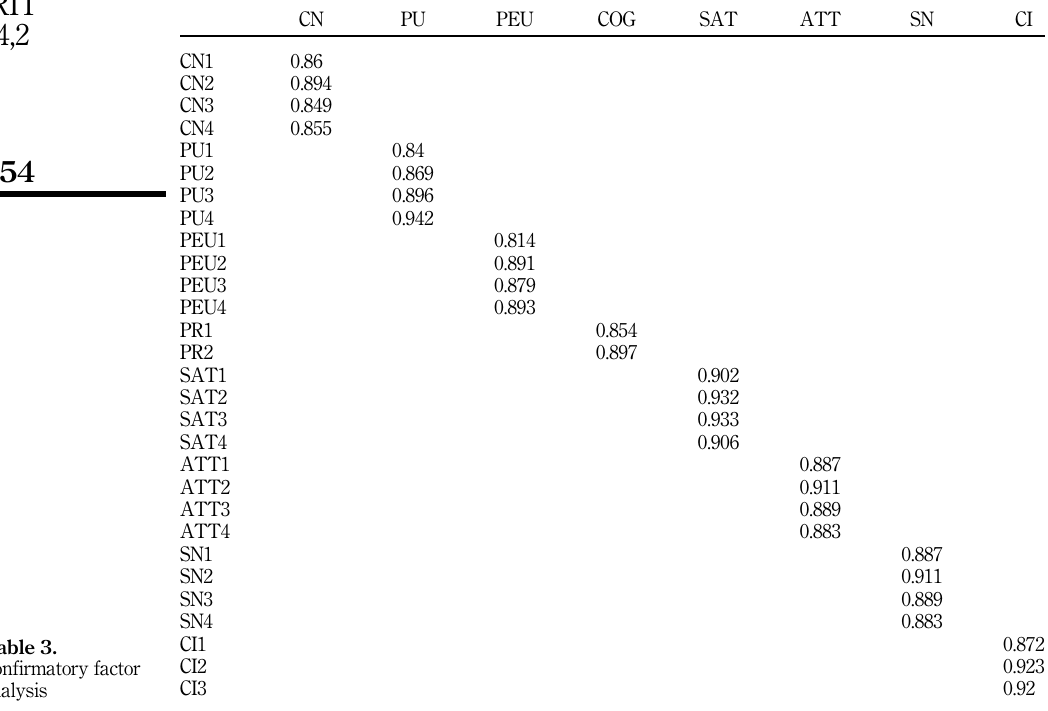
Table 3. Confirmatory factor